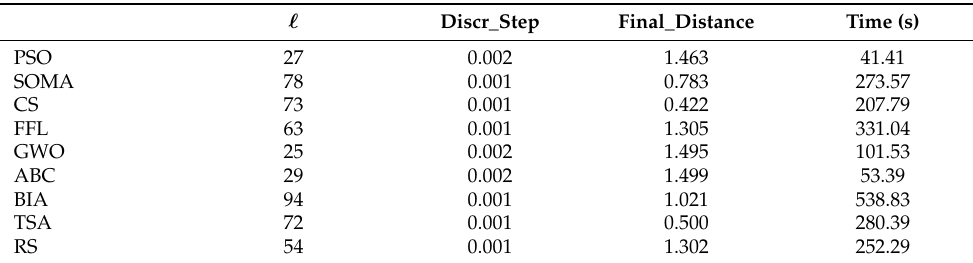
Table 14. The mean results for Function f 5 for 50 runs of evolutionary algorithms with a value of maxFES =